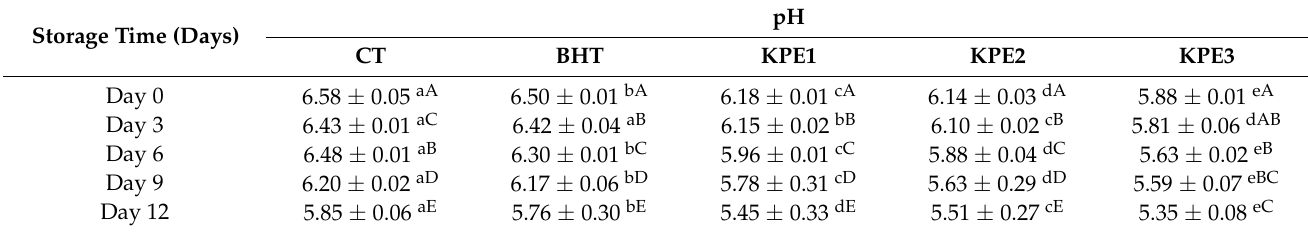
Table 3. pH values of beef sausages during 12 d of refrigerated storage.